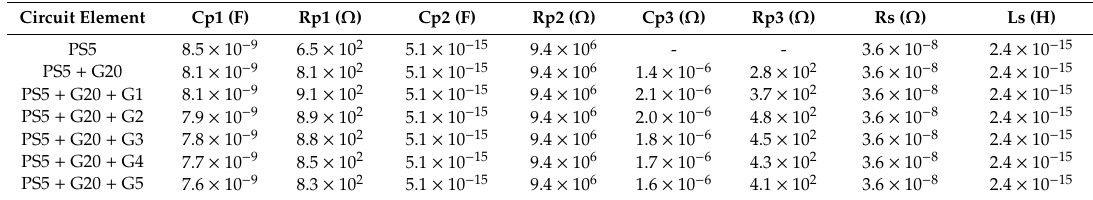
Table A7. Modeled impedance parameters Cp1, Rp1, Cp2, Rp2, Cp3, Rp3, Rs, and Ls of biochip pS5, with 10%